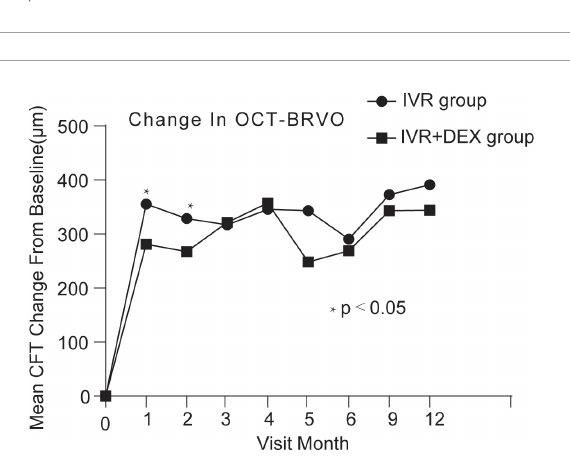
FIGURE4 CFT decreased over time compared to baseline: 12-month follow-up in both treatment groups after initial therapy in patients with CRVO.